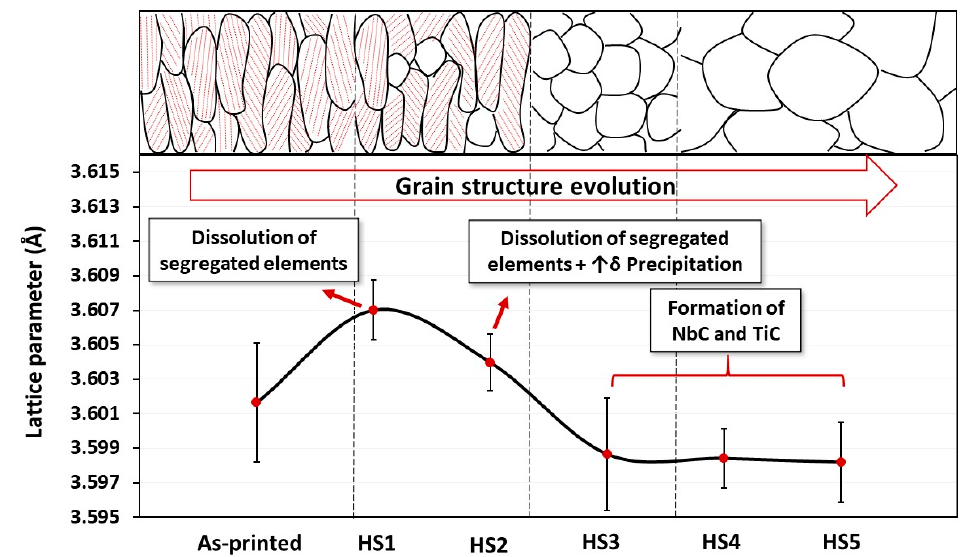
Figure 13. Evolution of the γ -matrix’s lattice parameter and grain structure as a function of the post-treatment conditions.